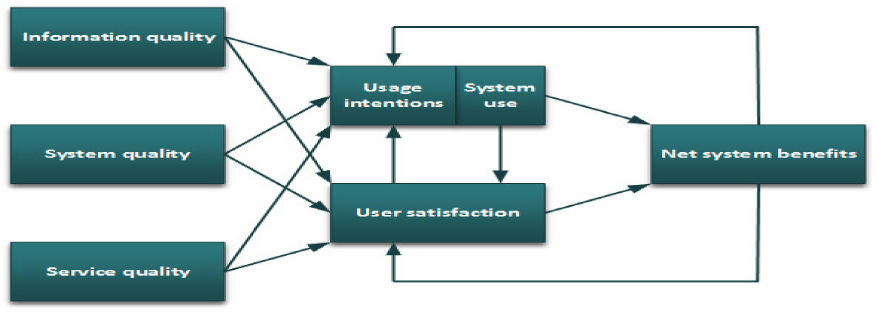
Figure 2. Information system success model